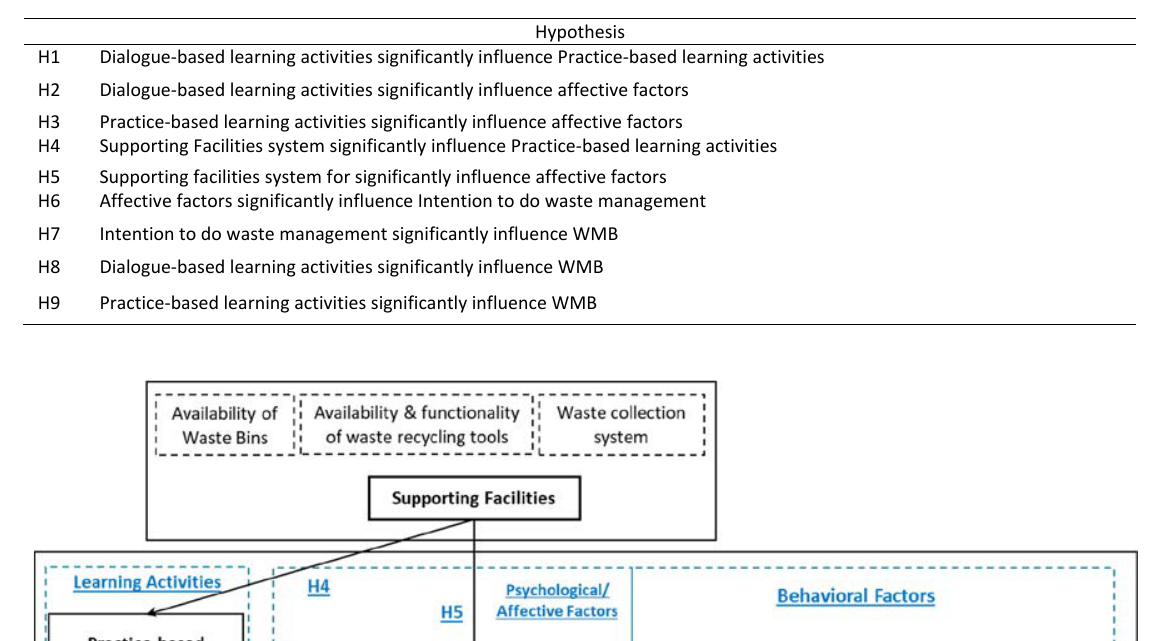
Table 2. Hypotheses of the quantitative phase